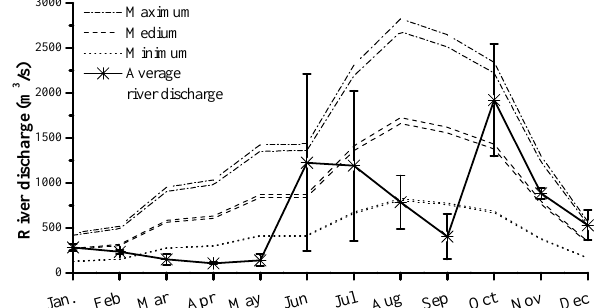
Fig. 6. Variation in natural river discharge (2005) and environmental flow in the Yellow River